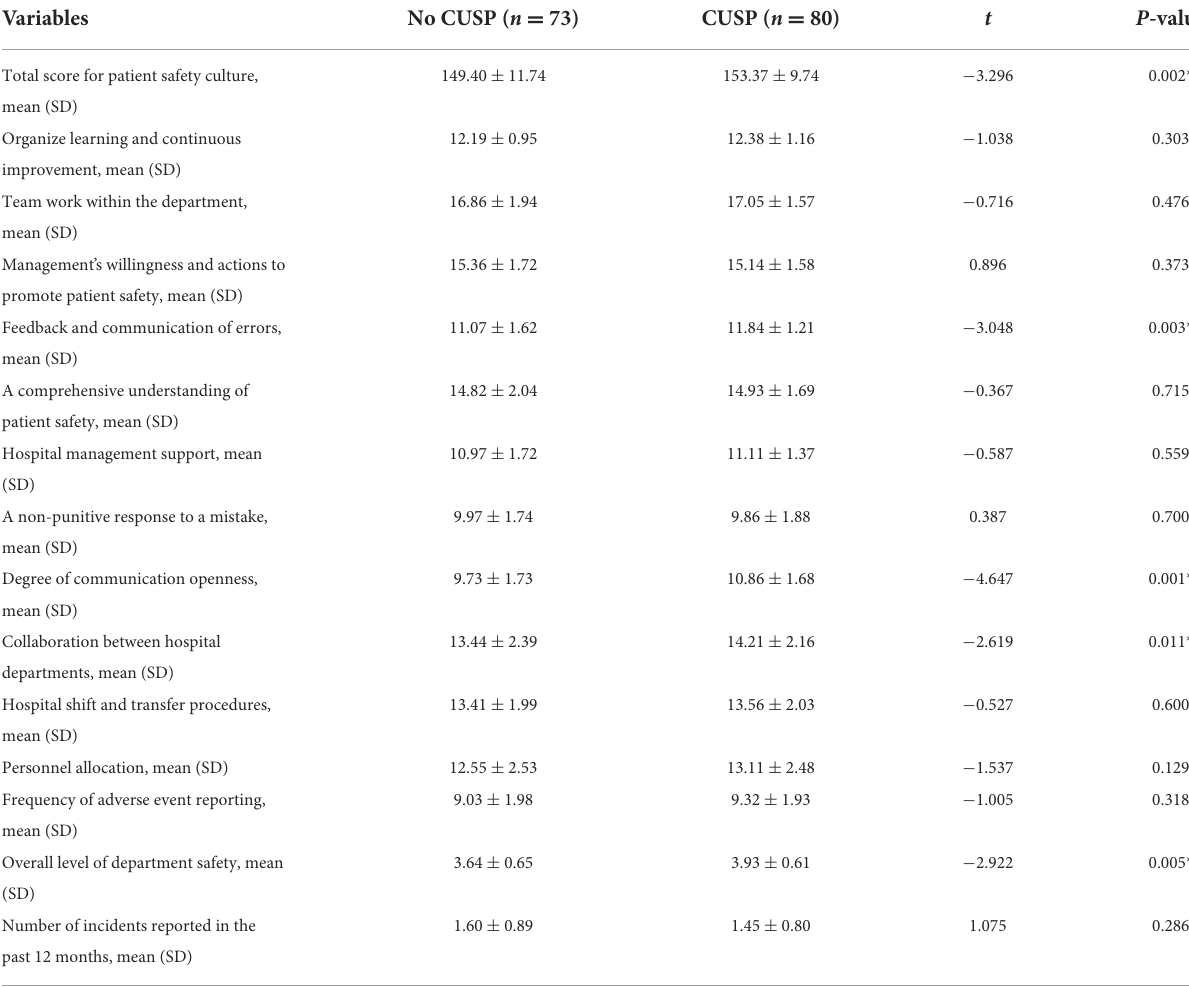
TABLE 7 Comparison of the safety management concept scores before and after the implementation of CUSP.